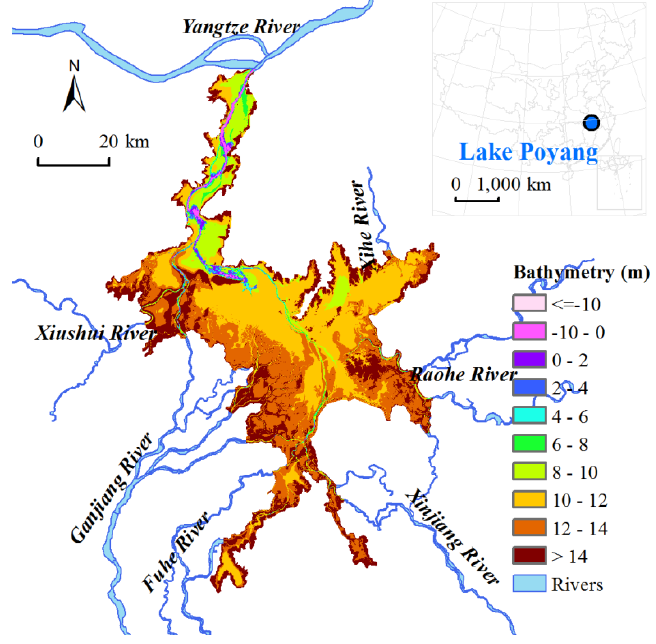
Figure 1. Location, bathymetry and connecting rivers of Lake Poyang, China.